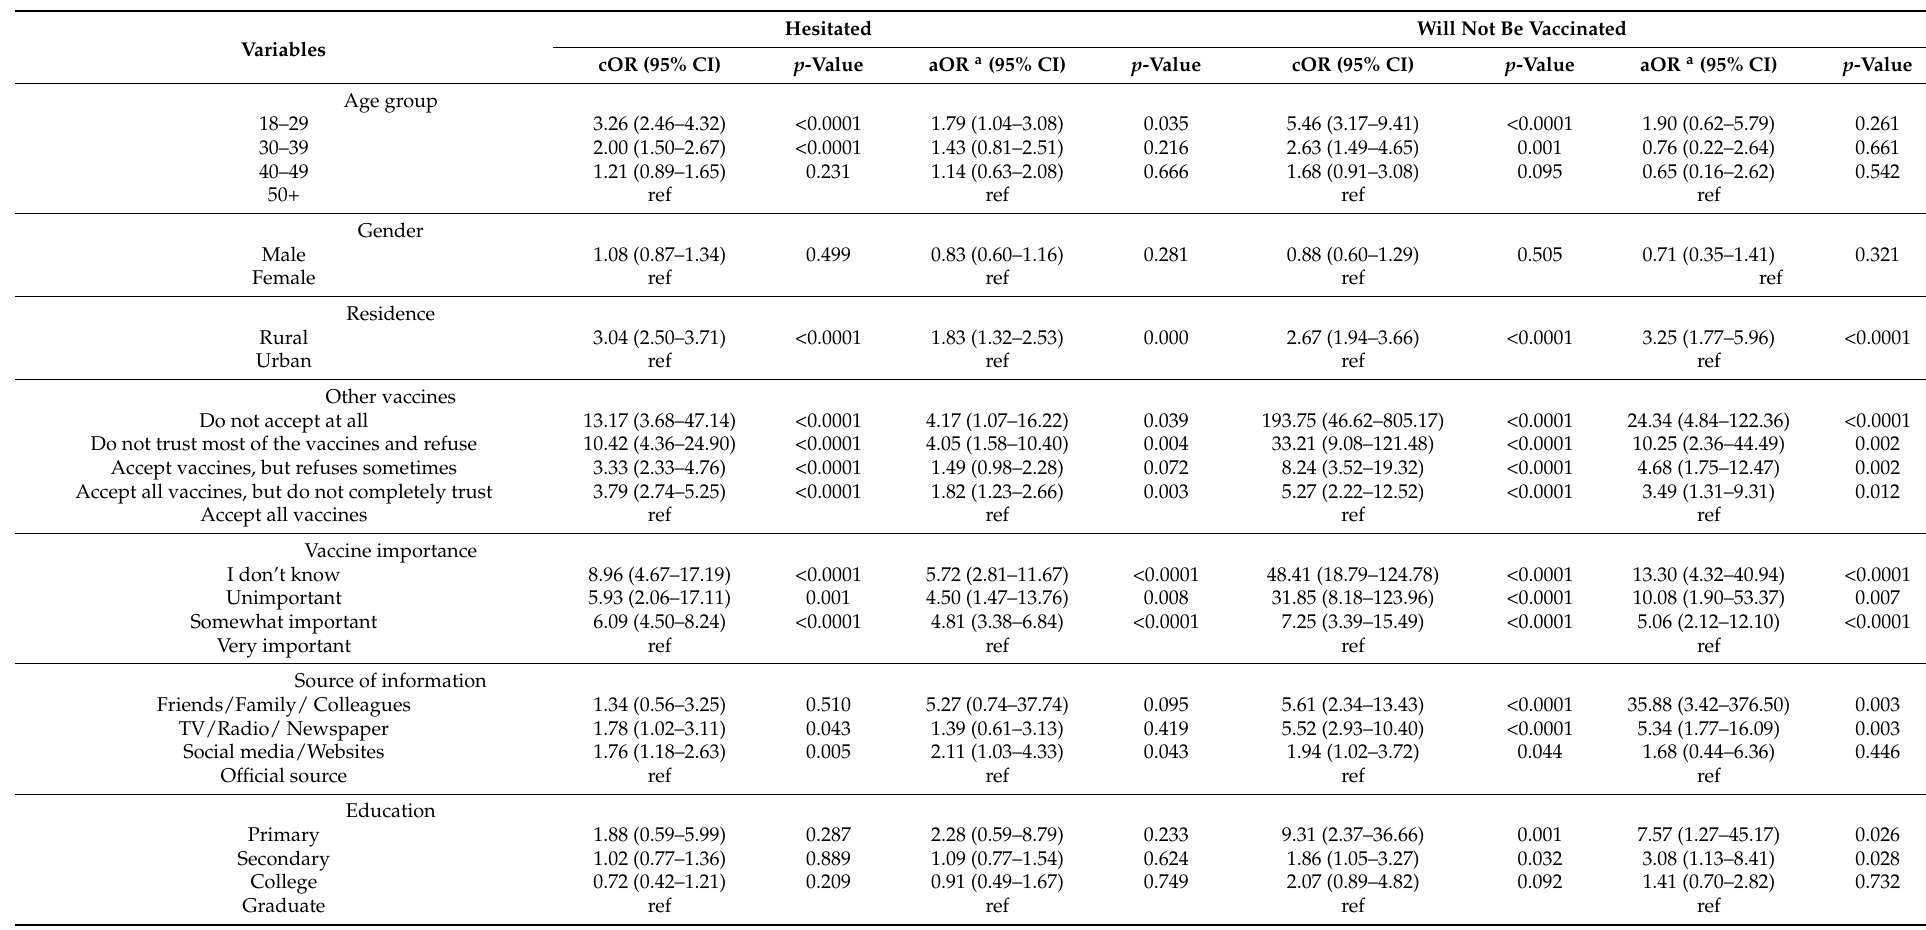
Table 10. Determinants and multinomial logistic regression analysis demonstrating factors associated with hesitance and refusal of a COVID-19 vaccine.